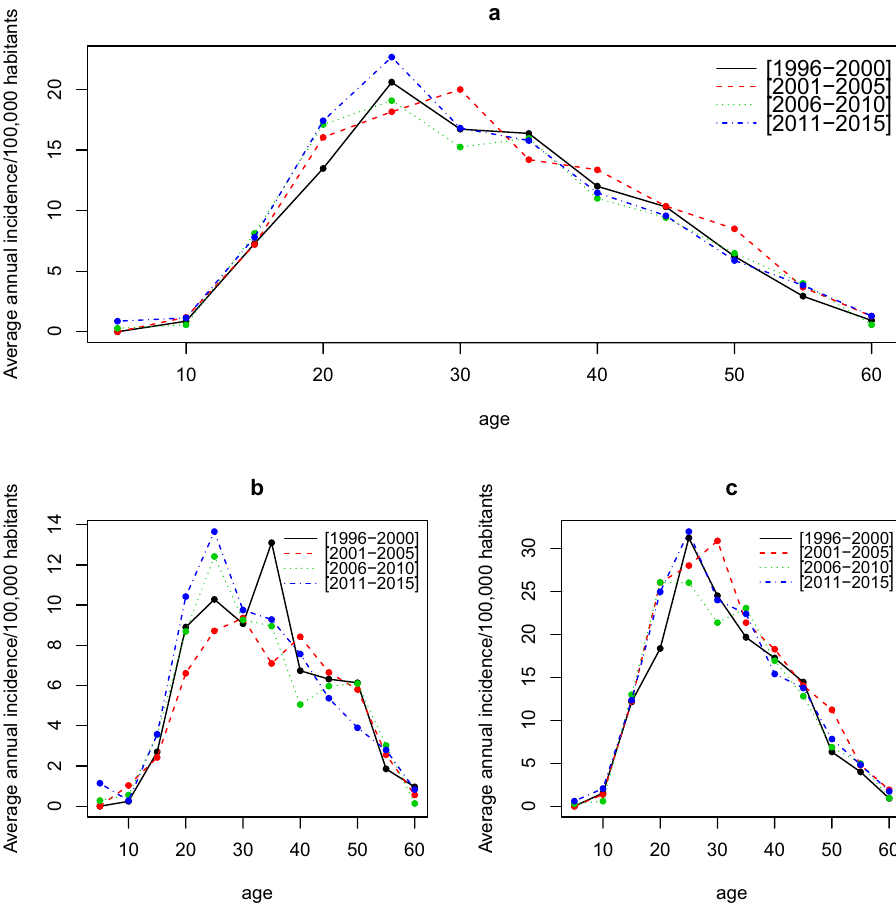
Figure 2. Time series of annual average incidence variation in multiple sclerosis per 100,000 population over age classes by period, all sexes combined ( a ), for men ( b ) and for women ( c